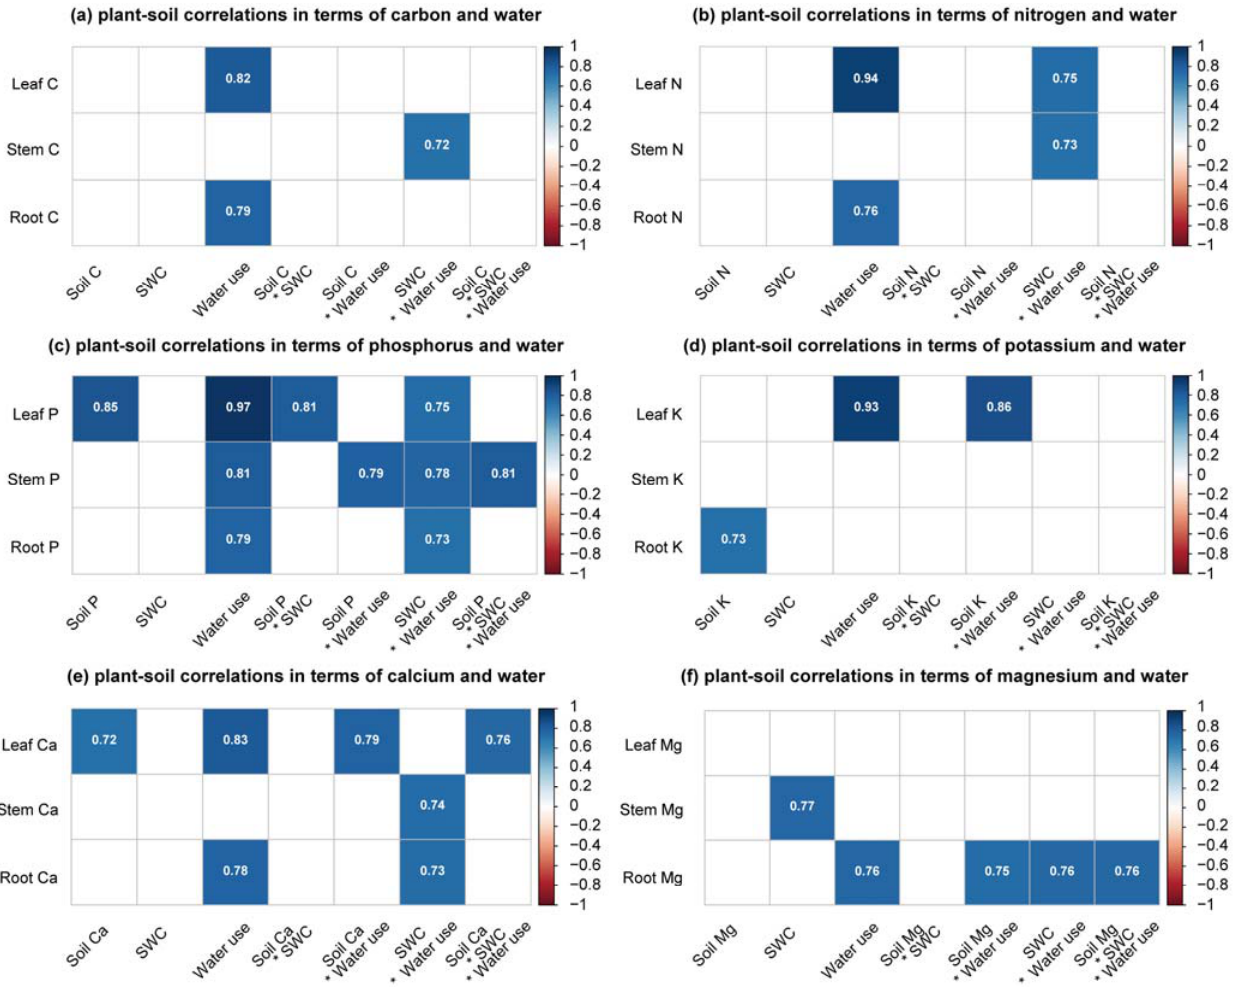
Figure 6. ( a – f ) Multiple correlations between plant tissue nutrients and soil nutrients and water. The asterisks are the connective symbols of the interaction terms of soil nutrients and water. The correlations shown are significant at the 0.01 level. The asterisk is the symbol of interaction.